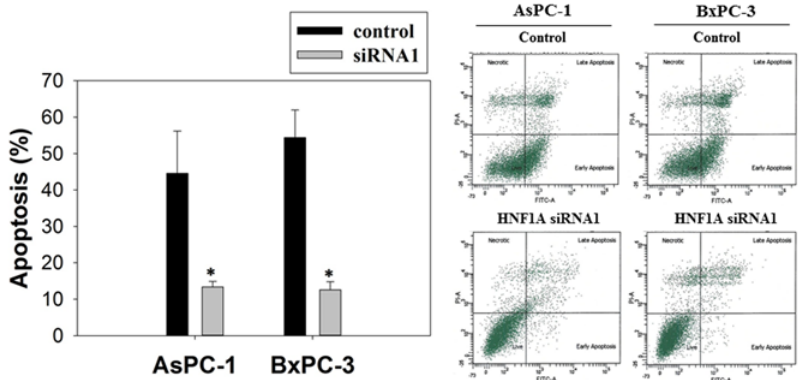
Fig 5. Effect of HNF1A knockdown on apoptosis. 72 h after transfection with anti- HNF1A siRNAs, the AsPC-1 and BxPC-3 cells were stained with FITC conjugated Annexin-V/PI. Percentage of Annexin- V/PI-stained cells was determined by flow cytometry. Dot plot was divided into a quadrant: (1) necrotic cells, (2) late apoptotic cells, (3) living cells, and (4) early apoptotic cells. Bar graph shows the percentage of apoptotic cells. Values are expressed as mean ± SD from three different experiments. * P < 0.05 compared with the control.